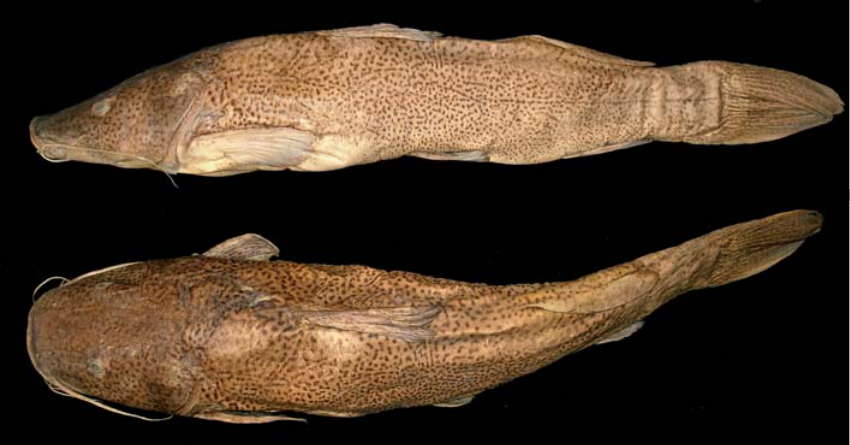
Fig. 8. Lateral and dorsal views of S. punctatum. MZUSP 87985, 632 mm SL, Jaguara, rio Grande, Cachoeira Mata-Doutor, downstream of Jaguara hydroeletric power dam, São Paulo,